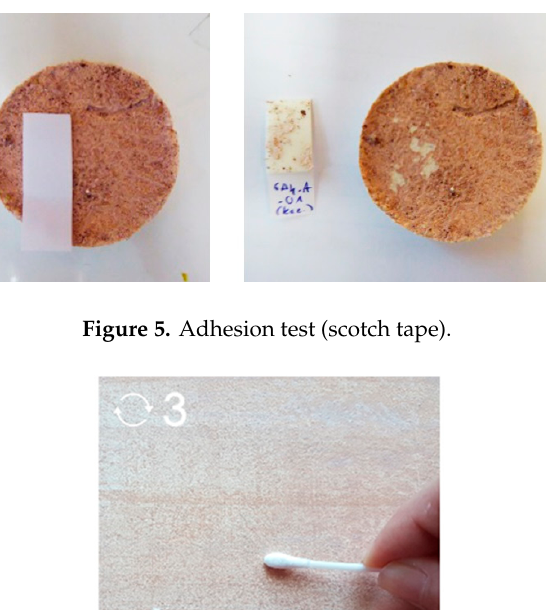
Figure 5. Adhesion test (scotch tape).